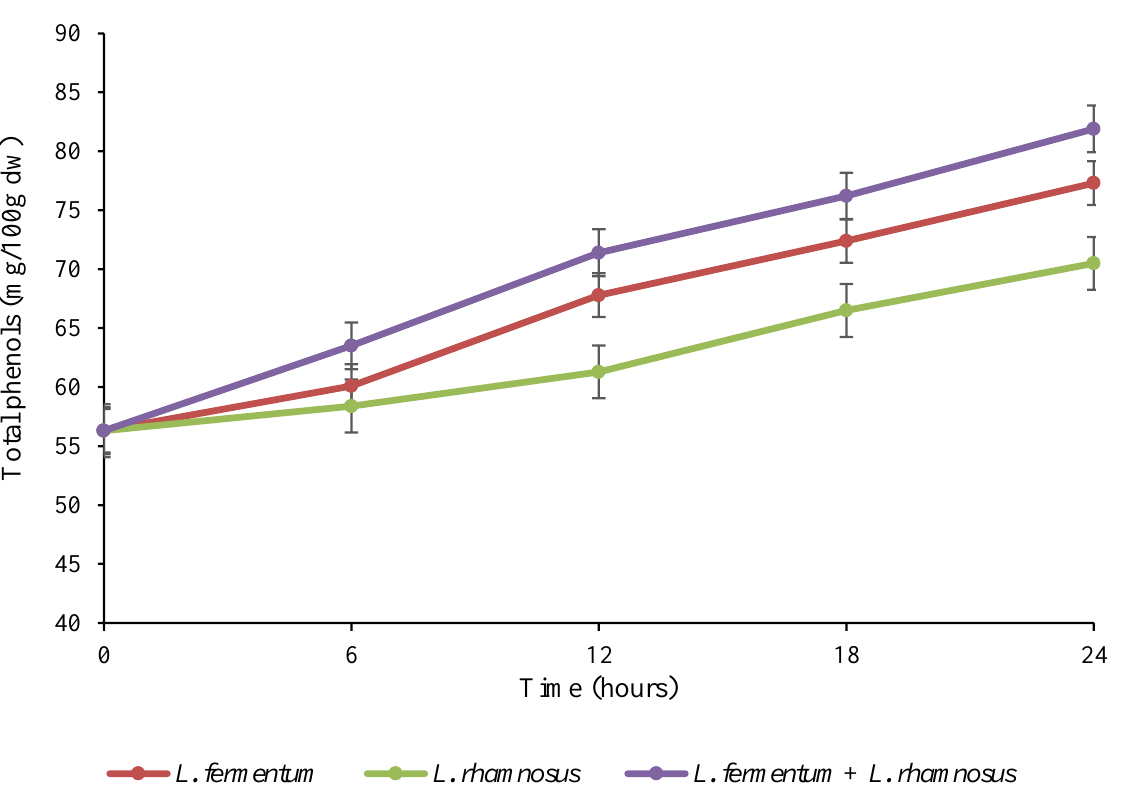
Figure 2. Variations in the total phenols (mg/100 g dw) in quinoa seed fermented by pure and binary mixed cultures of two Lactobacillus species. The error bars reveal the standard deviation of total phenols in quinoa seed over 24 h of fermentation. L. rhamnosus : Lacticaseibacillus rhamnosus mono- culture; L. fermentum : Limosilactobacillus fermentum monoculture; L. rhamnosus + L. fermentum : binary co-cultures of L. rhamnosus and L. fermentum.